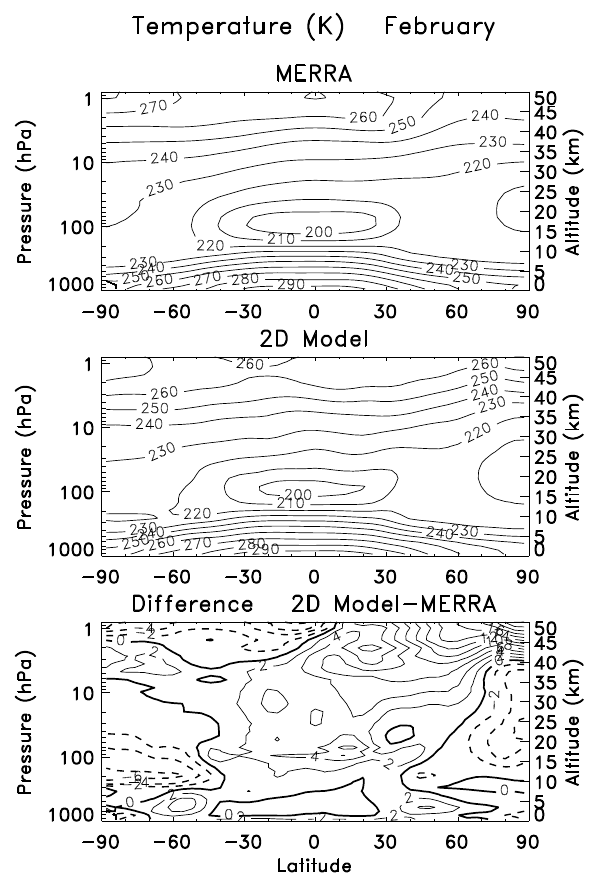
Figure B1. Latitude-height cross-sections of the February monthly mean temperature (K) from the Fig. B1. Latitude-height cross-sections of the February monthly MERRA data (top), 2-D model simulation (middle), and the difference, model minus MERRA (bottom mean temperature (K) from the MERRA data (top), 2-D model sim- ulation (middle), and the difference, model minus MERRA (bottom panel), all averaged over 1979–2009. The contour intervals are 10K for the top and middle panels and panel), all averaged over 1979–2009. The contour intervals are 10K ± 2 K for the bottom panel. The dashed contours in the bottom panel indicate negative differences. for the top and middle panels and ± 2K for the bottom panel. The figure dashed contours in the bottom panel indicate negative